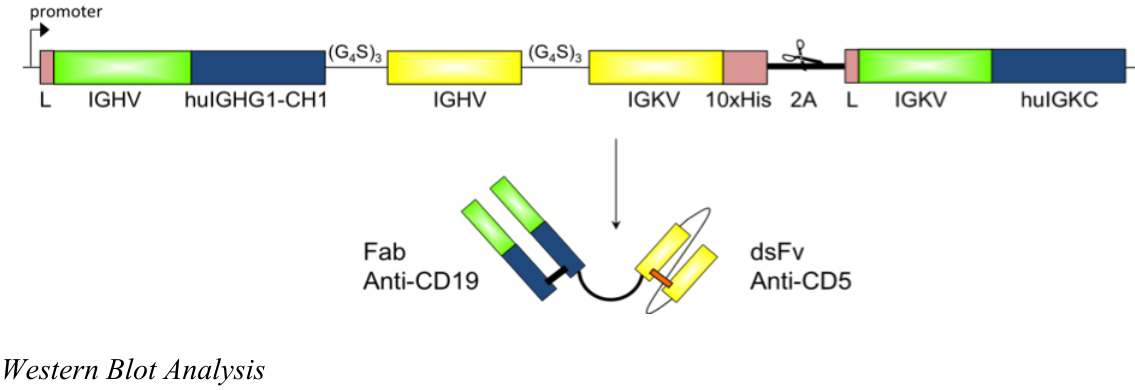
Figure 1. Schematic representation of genetic and protein organization of